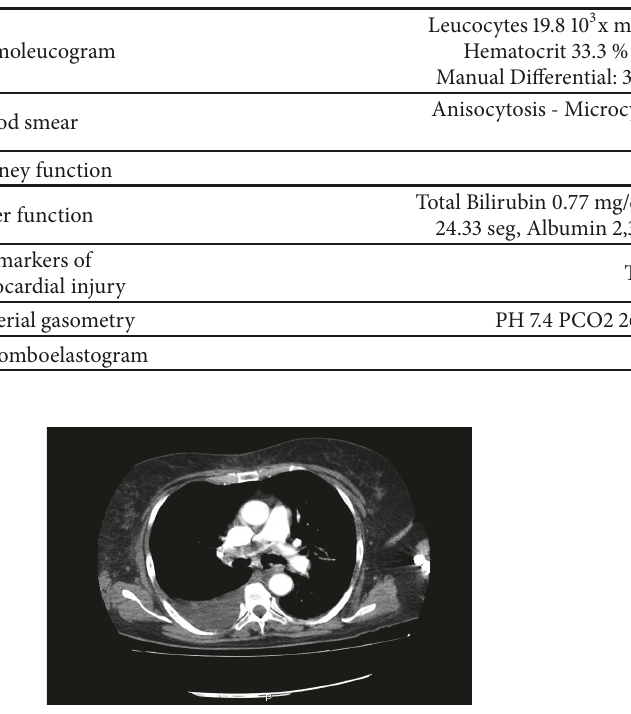
Figure 1: CT pulmonary angiography showing a large defect in the filling of the bifurcation and the right pulmonary artery.